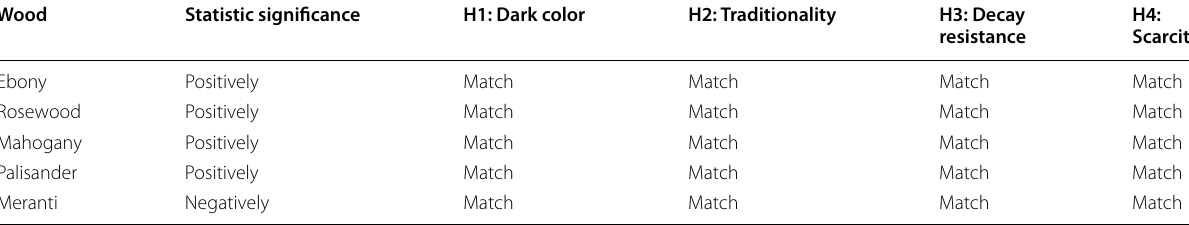
Table 8 Results of stepwise method for Yamaha (Analysis 1)